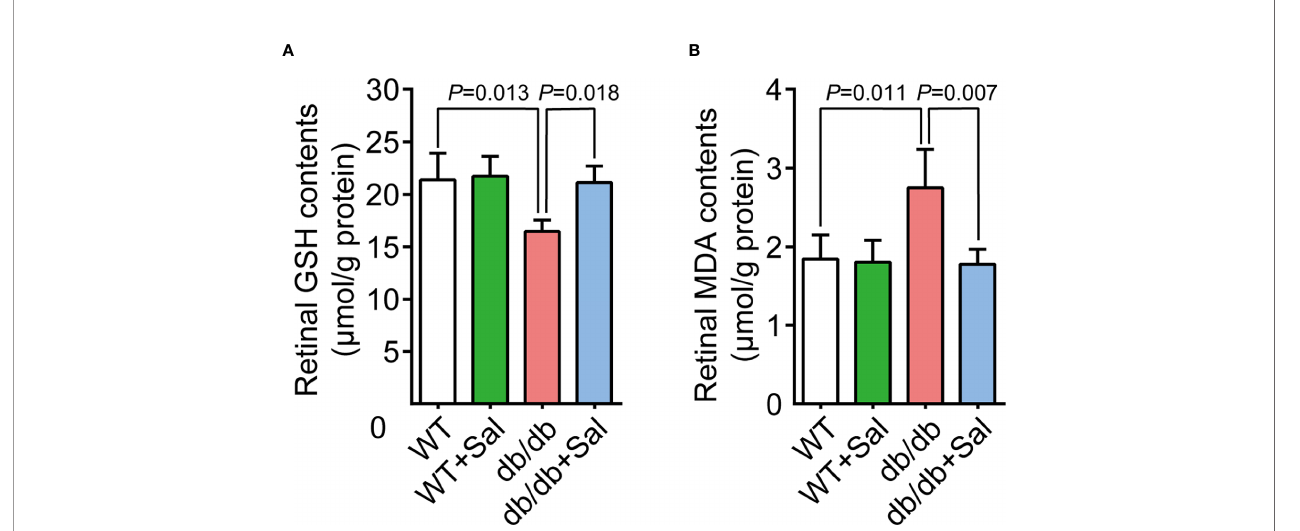
FIGURE 4 | Sal relieved retinal oxidative stress in db/db mice. (A) Retinal GSH contents in WT and db/db mice after Sal intervention. (B) Retinal MDA contents in WT and db/db mice after Sal intervention. Data are the mean ±